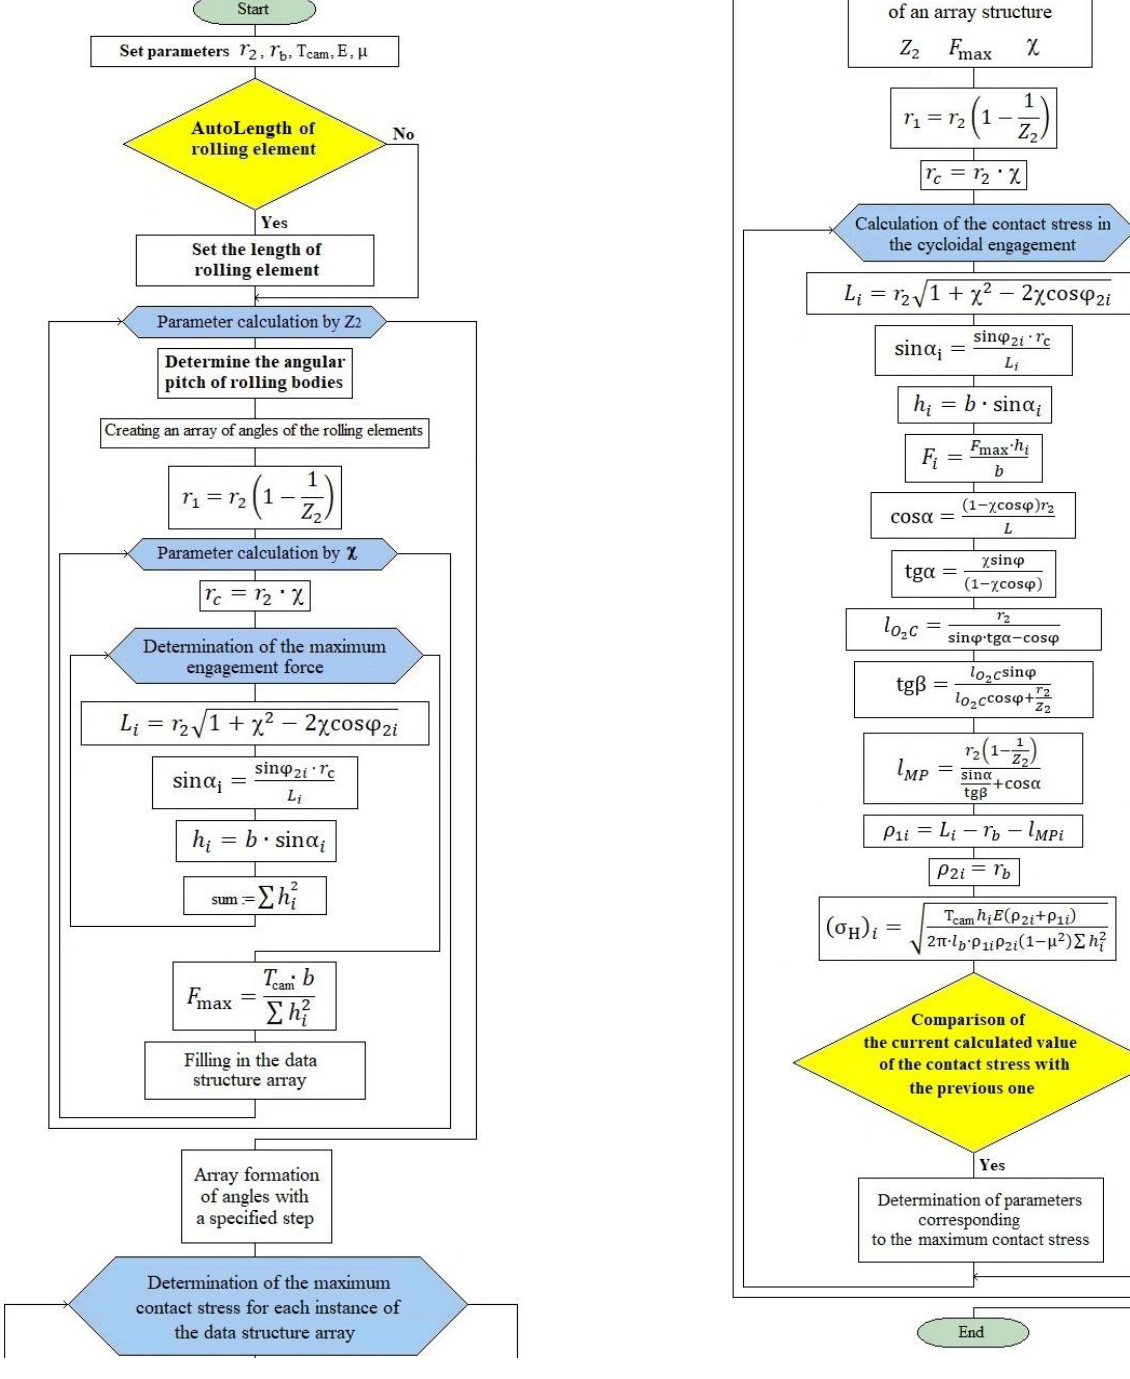
Figure 4. Algorithm for determining the maximum contact stresses in a cycloid.